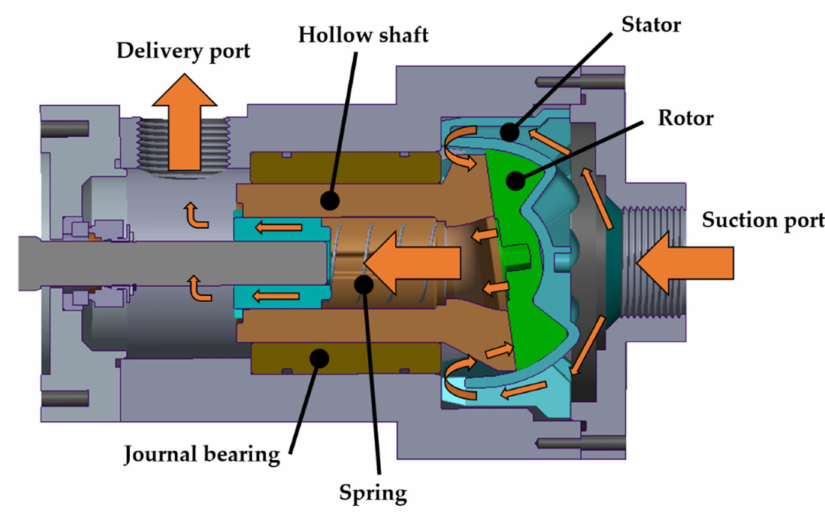
Figure 3. Sectional view through the TMC pump.